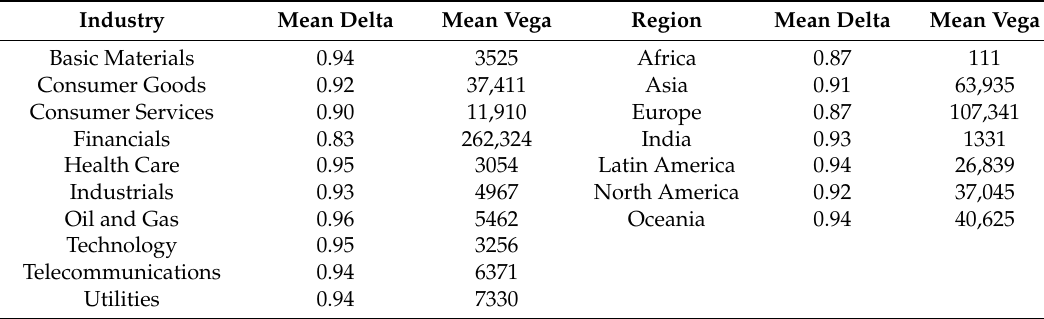
Table 2. Model sensitivity breakdown by industry and region 1